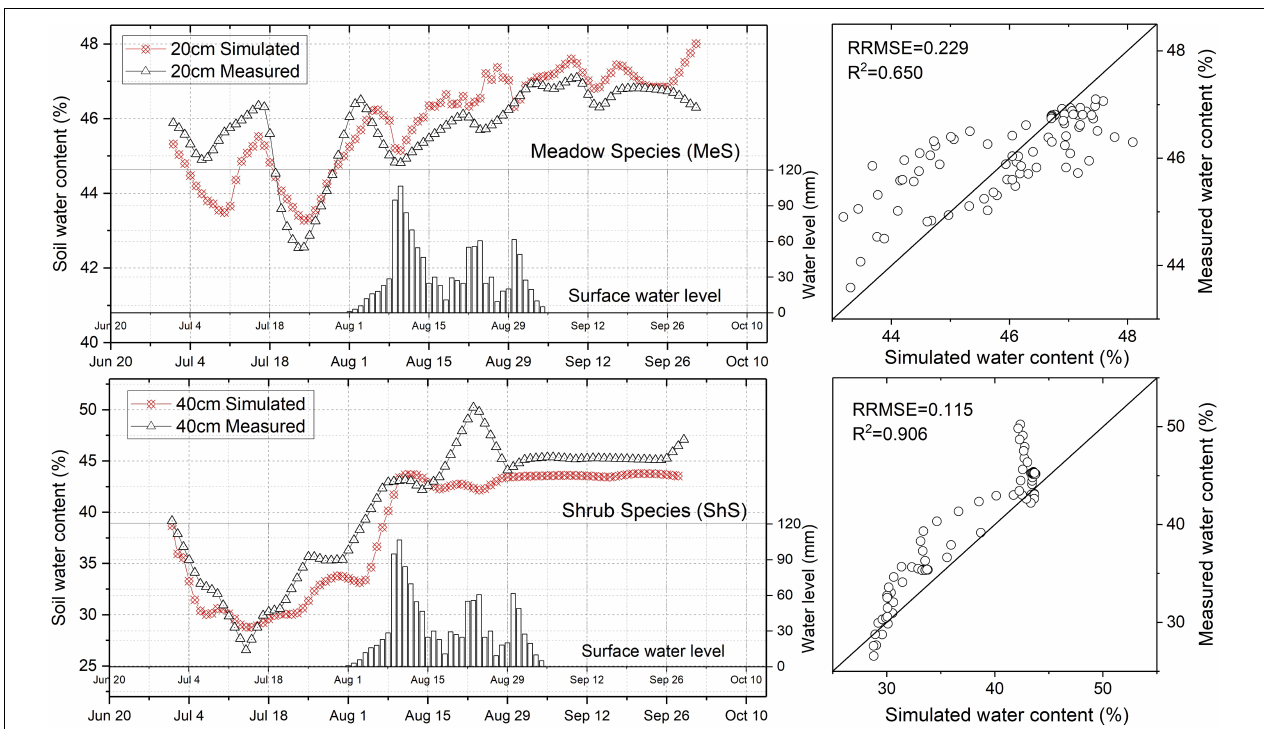
FIGURE 3 | Observed and simulated RZ-SWCs of the MeS and ShS at certain soil depths. Scatter tracks illustrate the difference between the observed and simulated RZ-SWCs by displaying the mean radically root square error (RRMSE) and the determination coefficient ( R 2